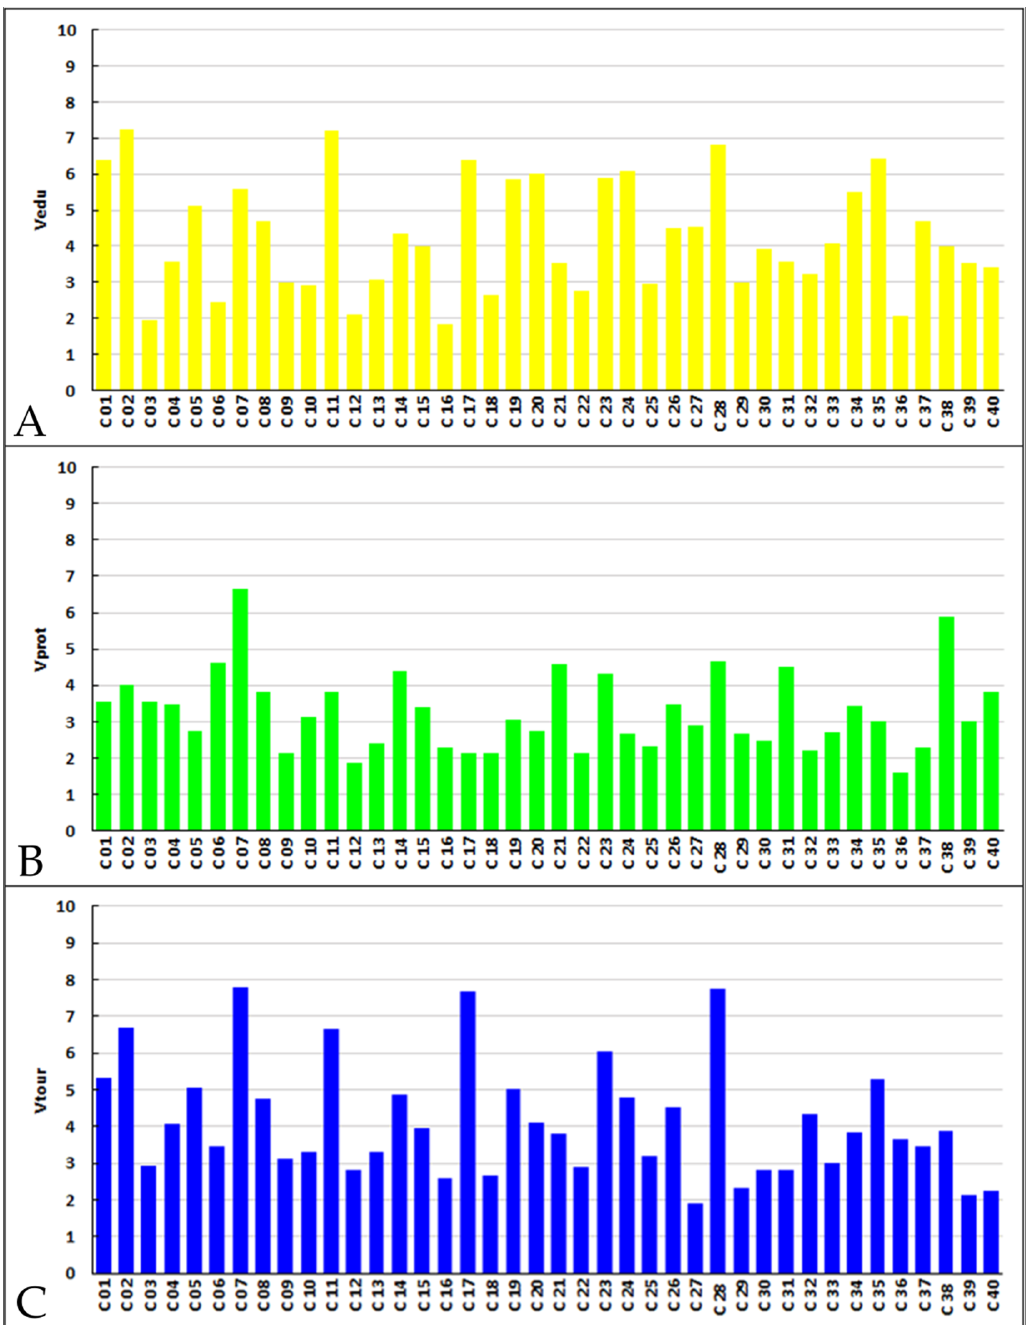
Figure 4. Diagrammatic representation of the results of the calculation of the three indices resulting from the assessment of Chelmos-Vouraikos UGGp geosites, ( A ) V edu , ( B ) V prot, ( C ) V tour .